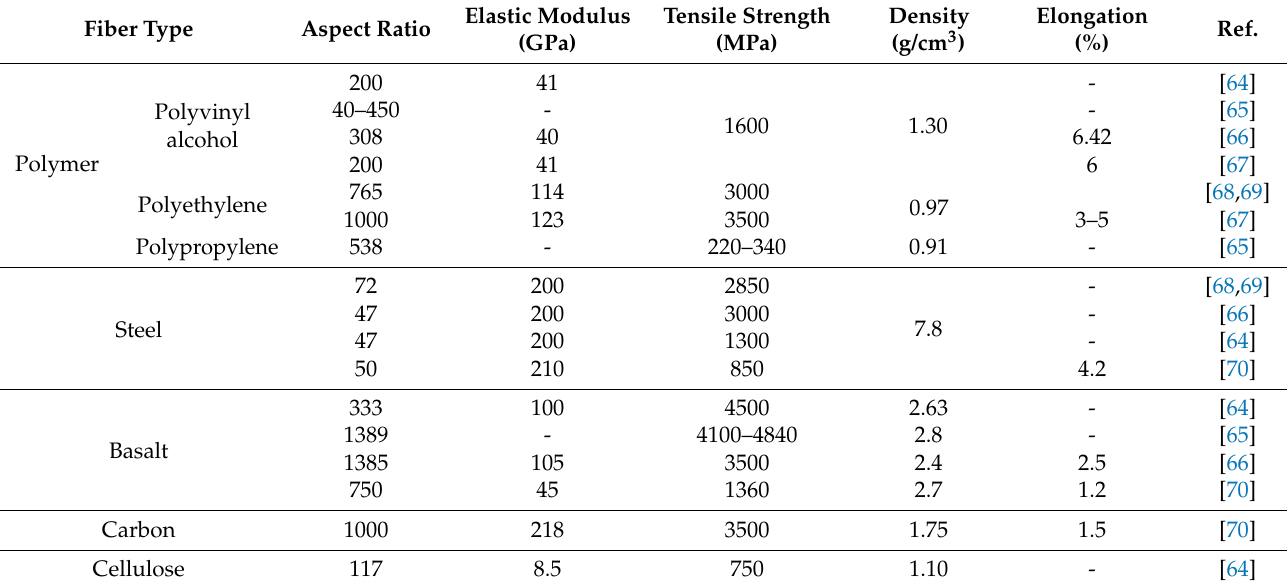
Table 1. Properties of fibers.